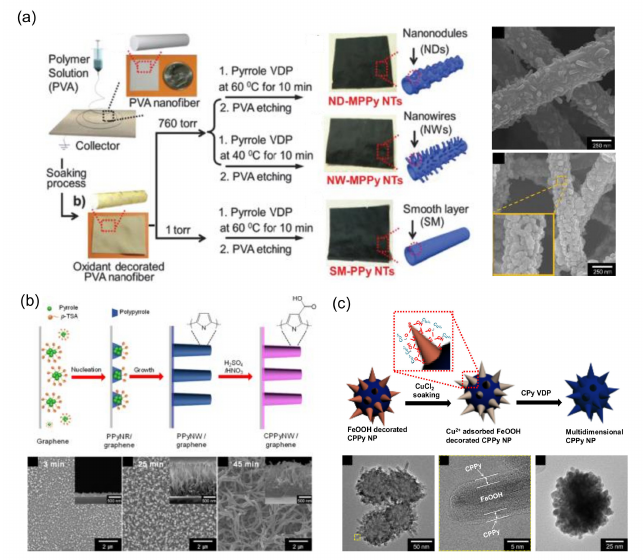
Figure 3. ( a ) Multidimensional PPy nanotubes based on electrospinning and vapor